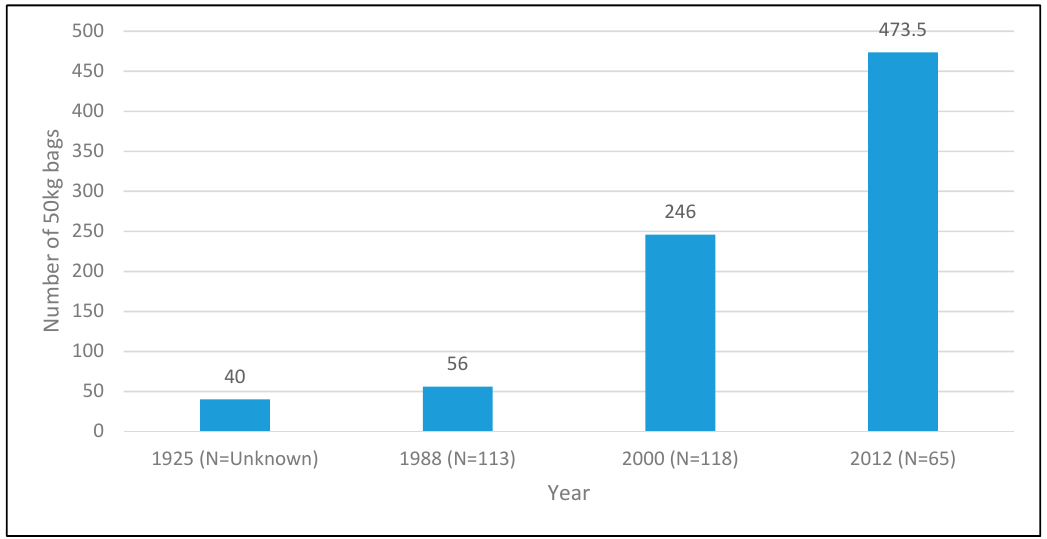
Figure 4. Cocoa output in the KNP between 1925 and 2012 (N=total study population). Sources: [68,75,76].